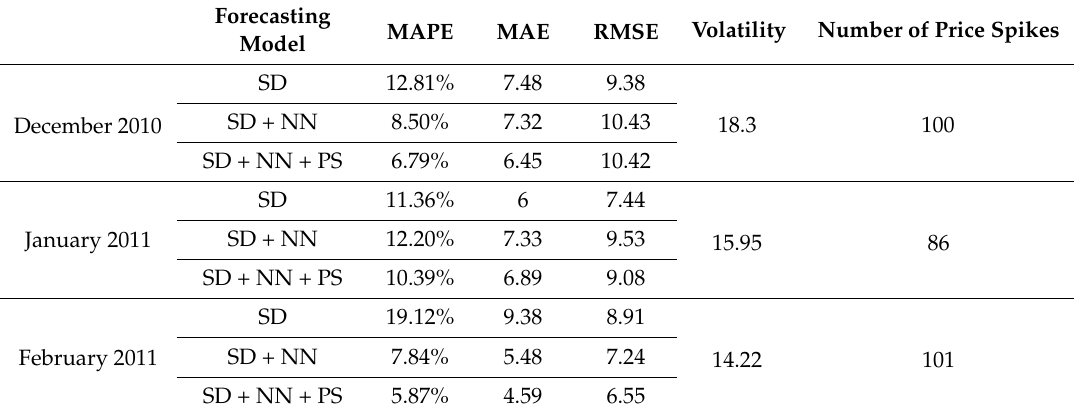
Table A1. Performances of the proposed hybrid model for hourly electricity price